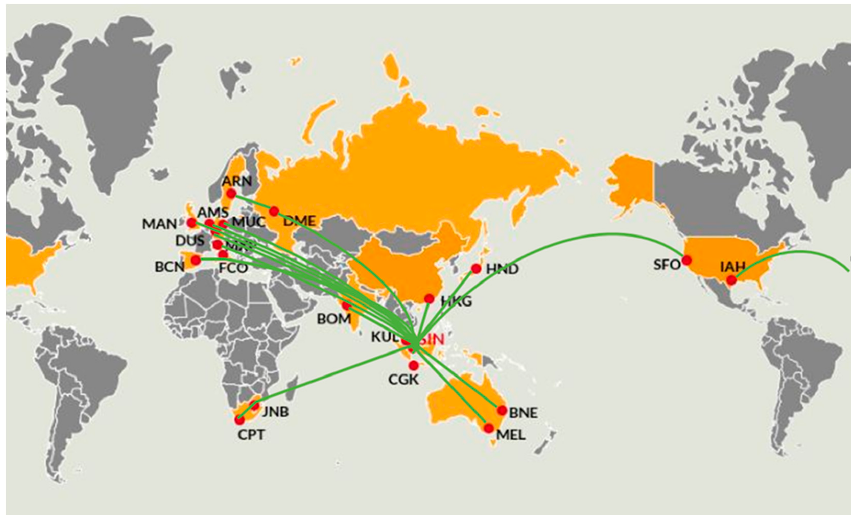
Figure 4. Singapore Airlines Airbus A350-900XWB aircraft routes as at 31 December 2017. Legend: AMS = Amsterdam, ARN = Stockholm Arlanda Airport, BNE = Brisbane, BCN = Barcelona Airport, BOM = Chhatrapati Shivaji International Airport (Mumbai), CGK = Jakarta, CPT-Cape Town, DME = Domodedovo Airport (Moscow), DUS = Düsseldorf, FCO = Leonardo da Vinci–Fiumicino Airport (Rome), HKG-Hong Kong, HND = Haneda Airport (Tokyo), IAH = George Bush Intercontinental Airport (Houston), JNB = Johannesburg Airport, KUL = Kuala Lumpur, MAN = Manchester Airport, MEL = Melbourne, MXP = Milan–Malpensa Airport, MUC = Munich Airport, SFO = San Francisco, SIN = Singapore.